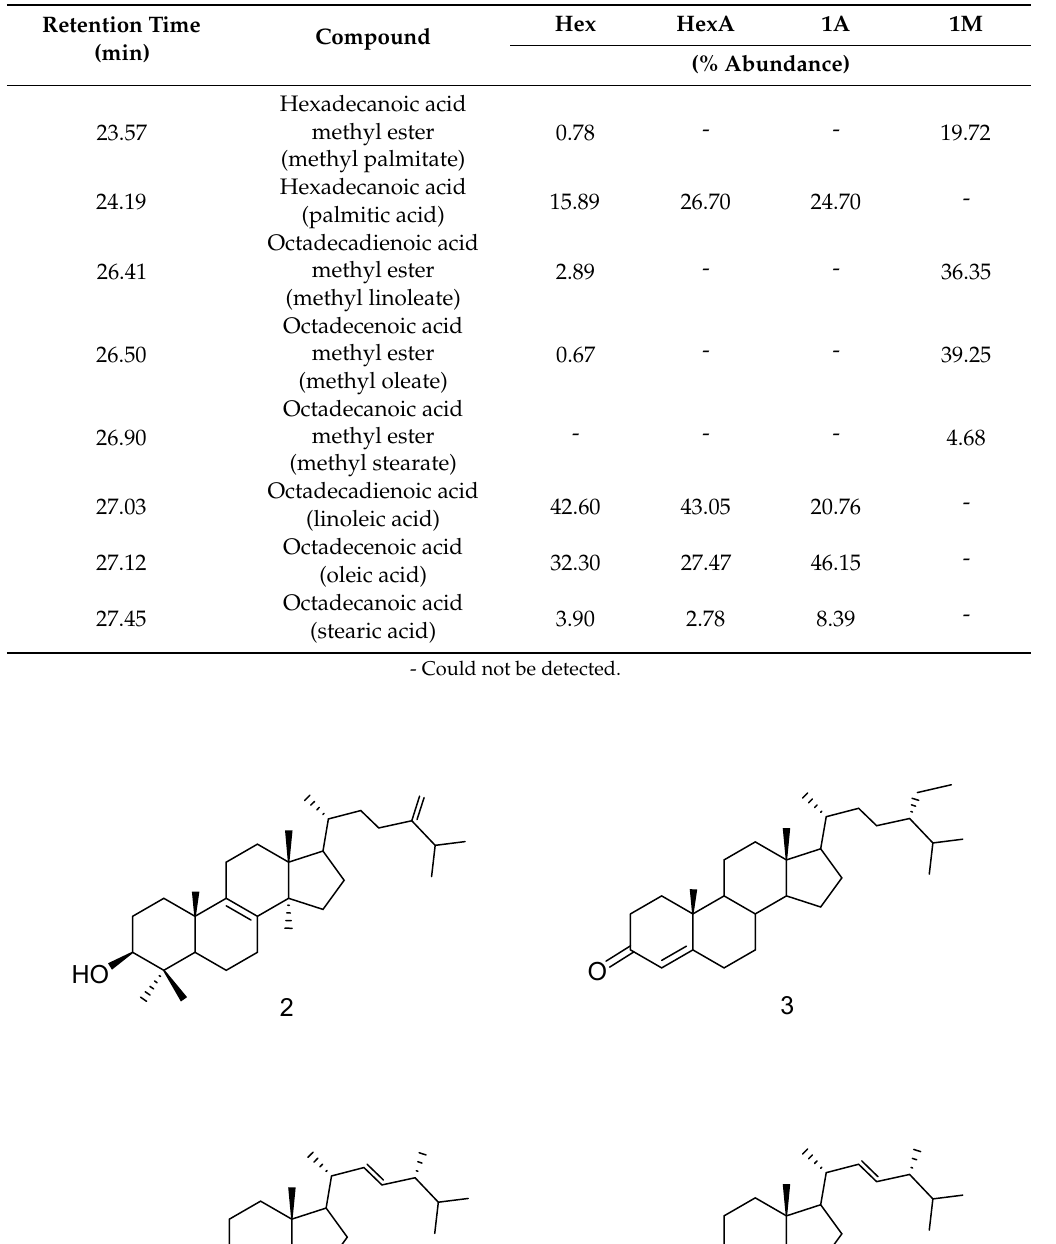
Table 3. GC-MS analysis of the EFI671 hexane extract (Hex), its acid fraction (HexA), the free fatty acids mixture (1A from the hydrolysis of 1) and their methylated esters (1M).